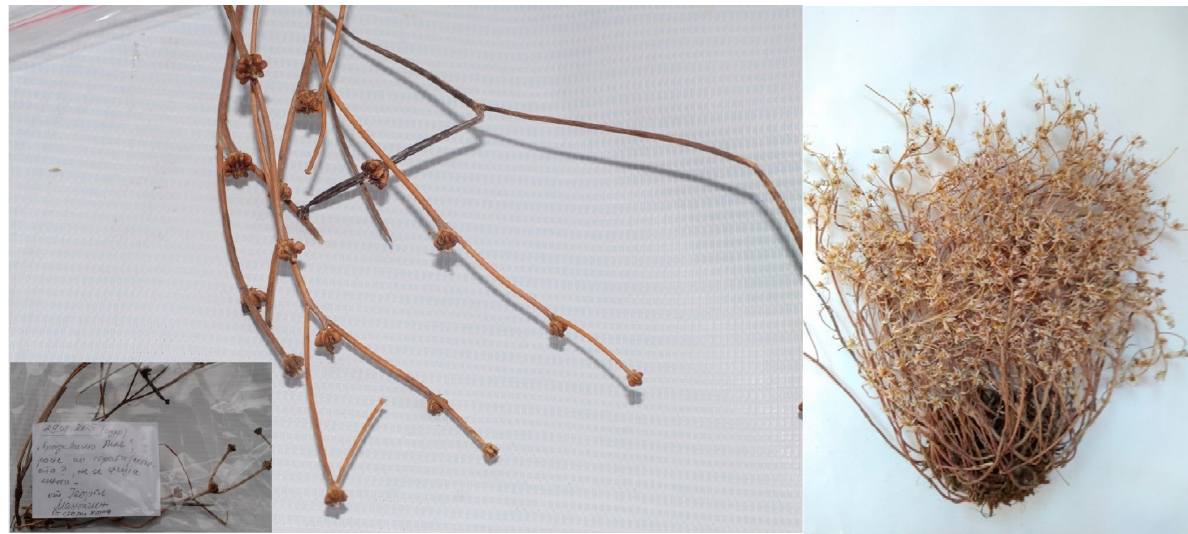
Figure 11. “ Брадавично биле ” Crepis zacintha (L.) Babc. and Sedum album L. Figure 11. “ Бр a д a вичн o биле ” Crepis zacintha (L.) Babc. and Sedum album